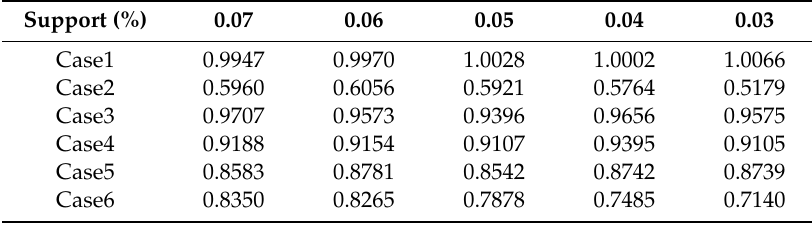
Table 2. Proportions of execution time for FDCNB-MINING / FLR-mining while varying support from 0.03% to 0.07% and for Case 1 to Case